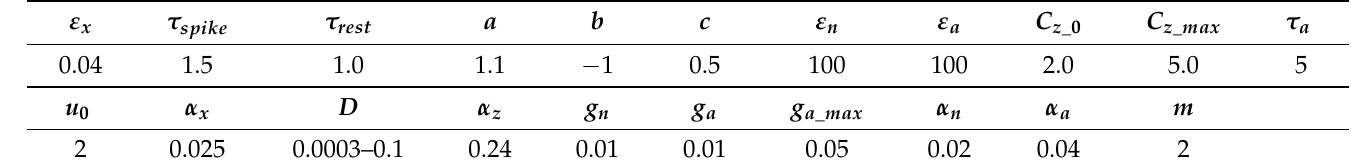
Table 1. The basic set of model control